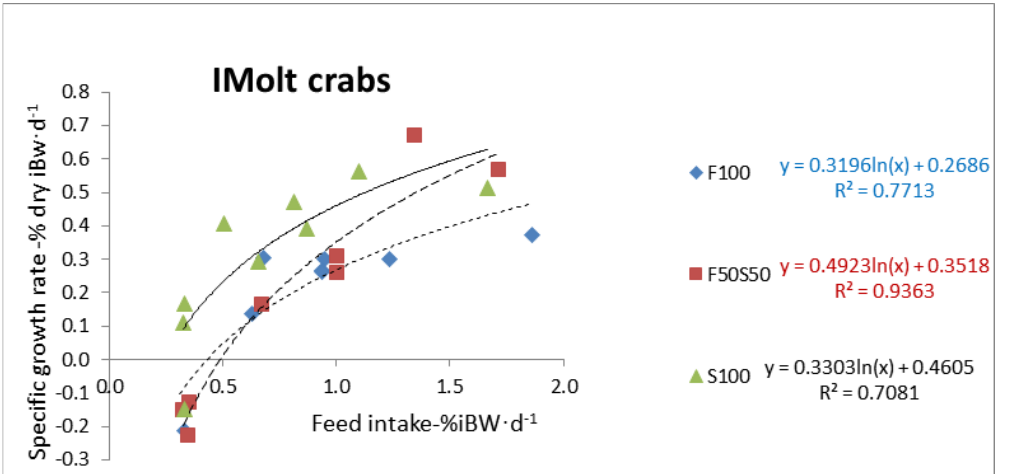
Figure 4. Relationship between specific growth rate (SGRd) and feed intake of juvenile crabs for the 3 experimental diets at IMolt crabs. Amount of feed intake is percentage of initial fresh body weight (iBW) per day.